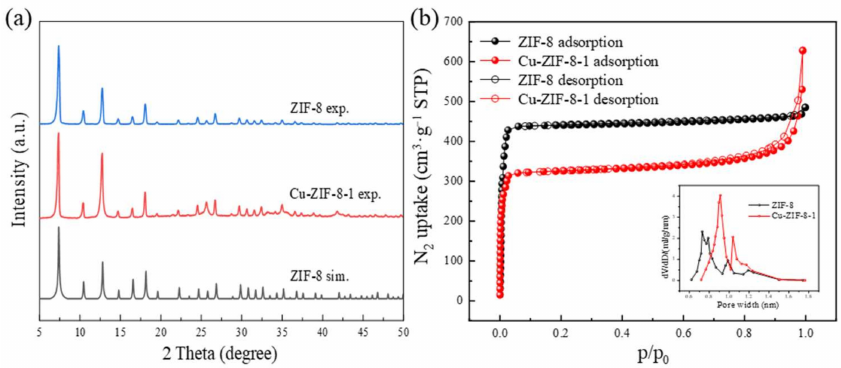
Figure 1. Powder X-ray diffraction (PXRD) patterns ( a ); N 2 adsorption-desorption isotherms and pore size distribution ( b ) of ZIF-8 and